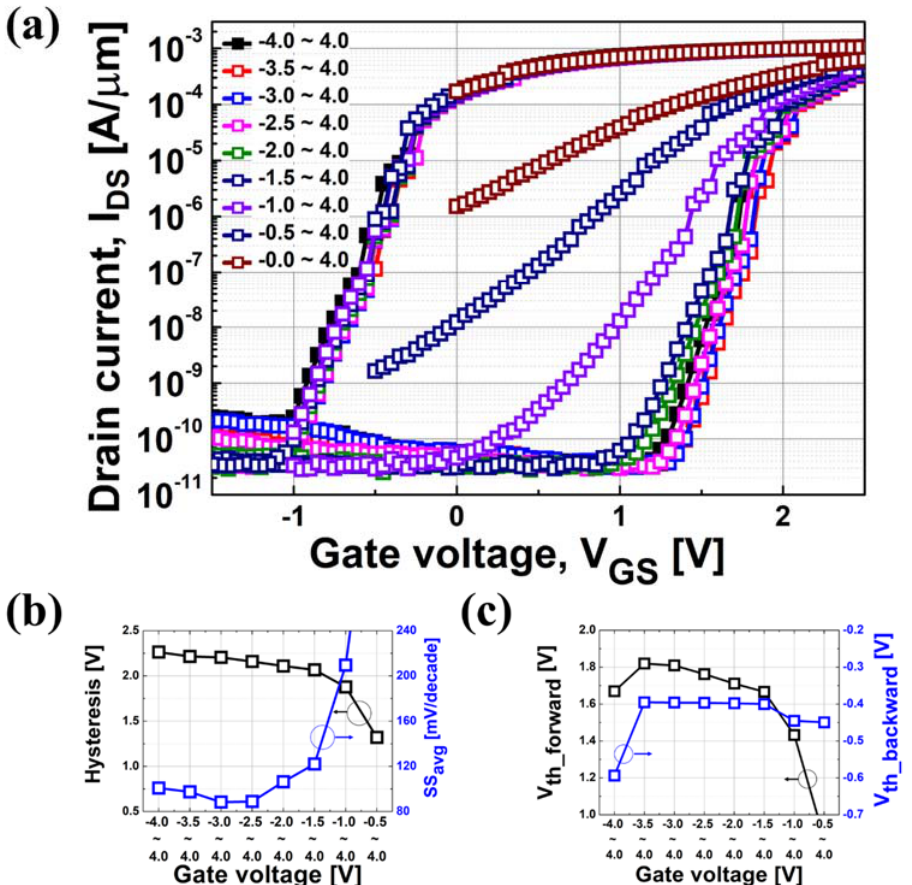
Figure 5. ( a ) Measured drain current versus gate voltage for various V GS_negative (i.e. from − 4 to 0 V) with the fixed V GS_positive (i.e., 4 V). ( b ) Hysteresis (left-axis) and SS avg_forwad (right-axis) versus gate voltage sweep range plots of the Fe-FinFET. ( c ) V th_forward (left-axis) and V th_backward (right-axis) versus gate voltage sweep range plots of the Fe ‐ FinFET.